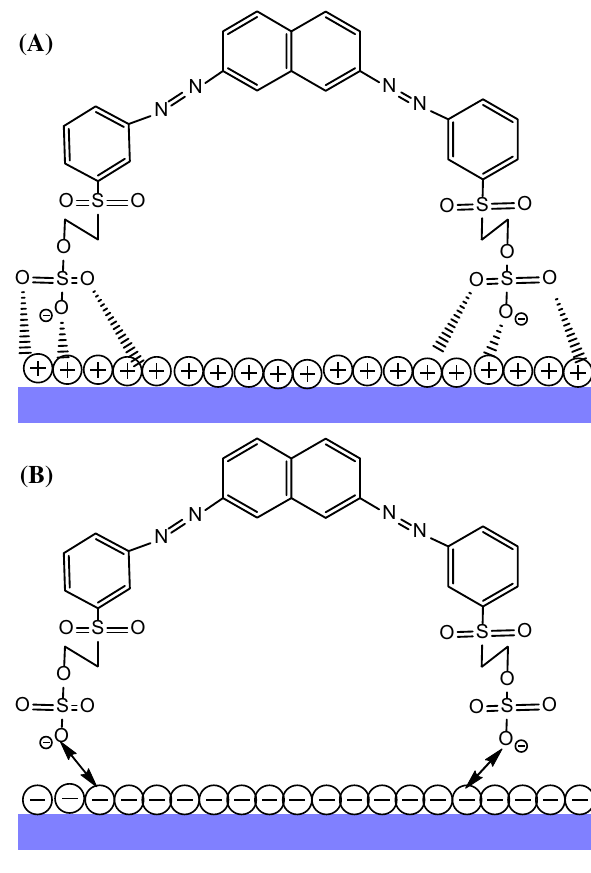
Fig. 7 Schematic reaction mechanism of RB5 and TiO a acid sites and b basic